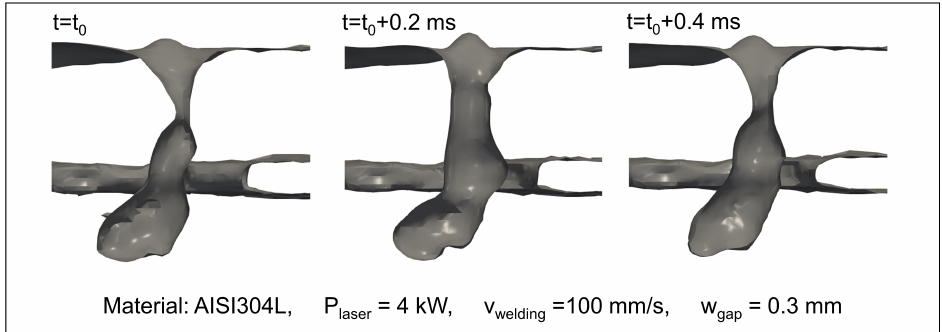
Figure 6. Surface wave structures on the keyhole wall on a mesh where the characteristic cell length is roughly equal to 1/8 · w gap